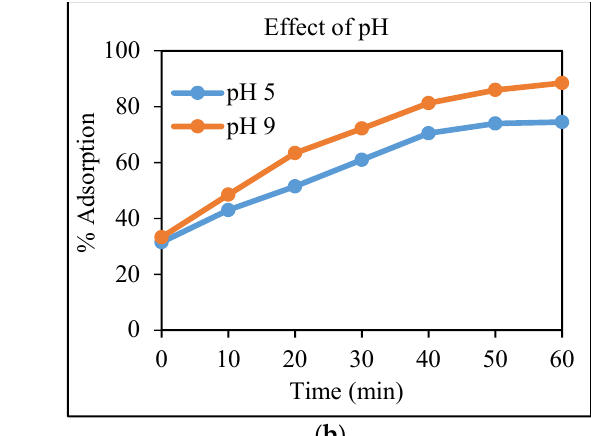
Figure 6. Removal (in percentage) of Cd ( a ) and Cr ( b ) using the CeO 2 /corncob nanocomposite as a function of adsorbent dose. 3.4.3. Effect of Concentration The purpose of this experiment was to investigate the effect of initial concentration on the adsorption of heavy metals (Cd and Cr) on the CeO 2 /corncob nanocomposite. In this study, to investigate the effect of the adsorbate’s initial concentration, two adsorbate concentrations were chosen, namely 10 ppm and 20 ppm. According to the experimental results given in Figure 7, it can be concluded that the adsorption process increases with